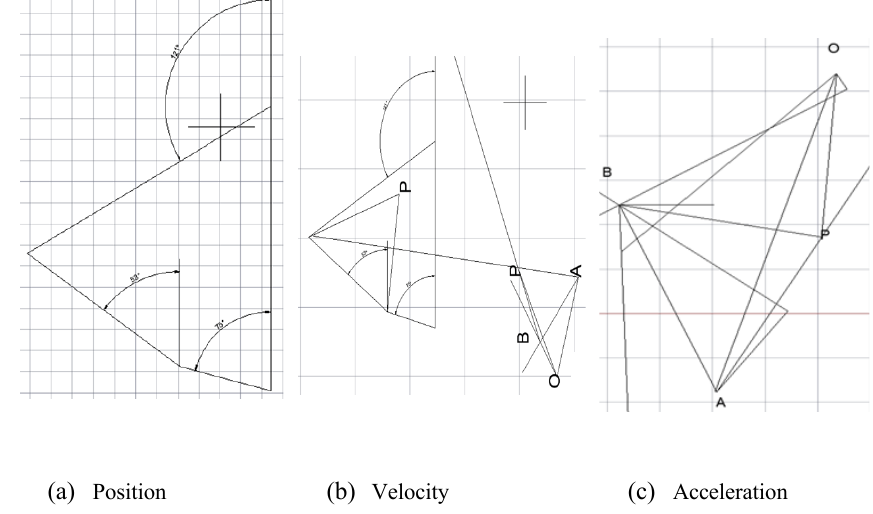
Fig. 3. Example of CAD drawn kinematic analysis